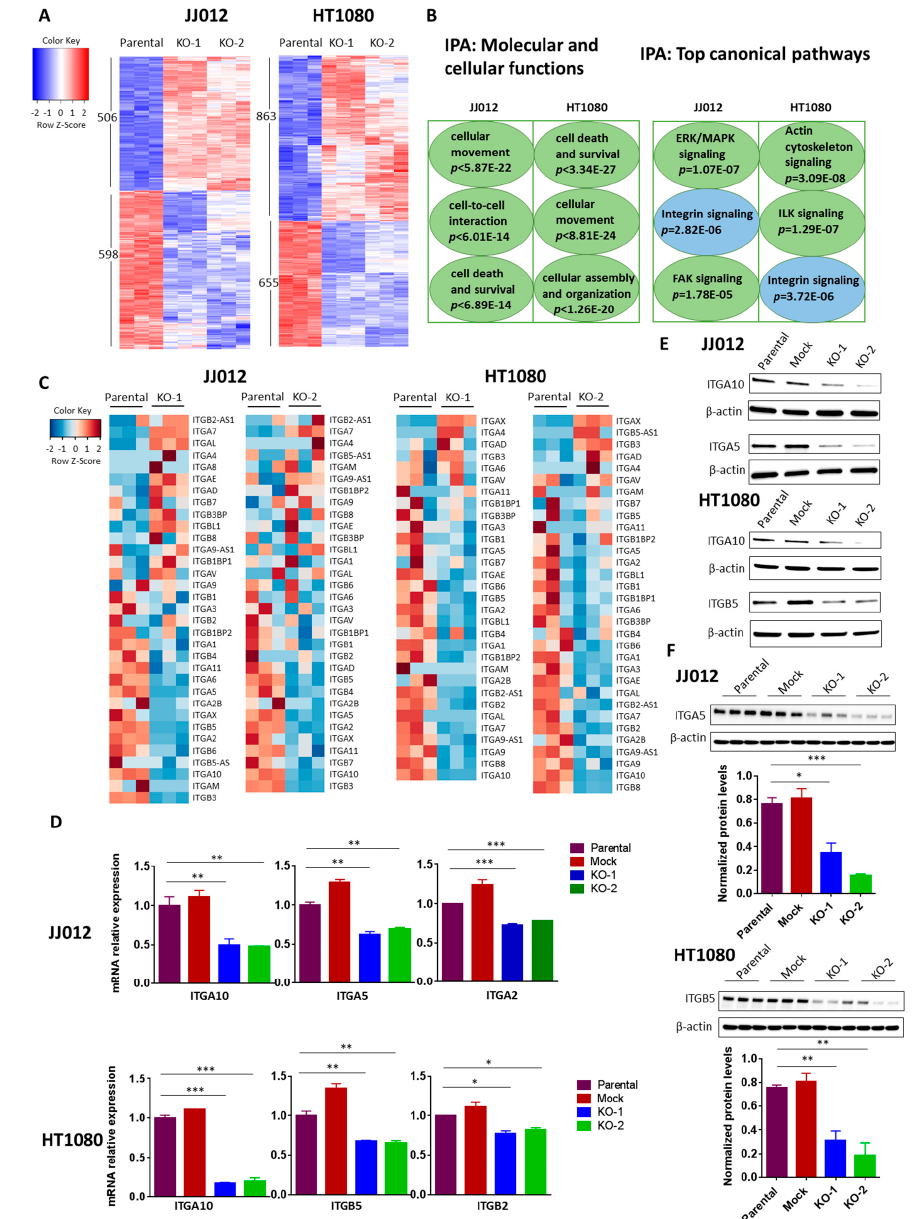
Figure 5. Effects of IDH1 mut knockout on gene expression in chondrosarcoma cell lines. ( A ) Heatmaps of differentially expressed genes in two IDH1 mut KO clones compared to parental control of each cell line. RNA-Seq analysis was performed in triplicate. Upon IDH1 mut knockout, the expression of 1104 genes and 1518 genes changed significantly in JJ012 and HT1080 cells, respectively (FDR-adjusted p value < 0.05). ( B ) IPA was performed with RNA-Seq data obtained in ( A ). ( C ) Heatmaps show the expression profiles of integrin genes upon IDH1 mut knockout. ( D ) Expression of ITGA10, ITGA5 and ITGA2 in the indicated groups of JJ012 cells; ITGA10, ITGB5 and ITGB2 in the indicated groups of HT1080 cells was quantified by qRT-PCR. The amount of transcript was normalized to GAPDH and the results are shown as fold-change relative to the parental control. Data are shown as mean ± SEM of triplicate values and are representative of three independent experiments. ( E ) Immunoblots of total protein lysates from control and IDH1 mut KO cells, probed with the indicated anti-integrin antibodies. ( F ) Immunoblots of total protein lysates from control and IDH1 mut KO tumors, probed with the indicated anti-integrin antibodies. Quantitation of signal in each group is normalized to β -actin. Three representative tumors per group are shown. * p < 0.05, ** p < 0.01, *** p <